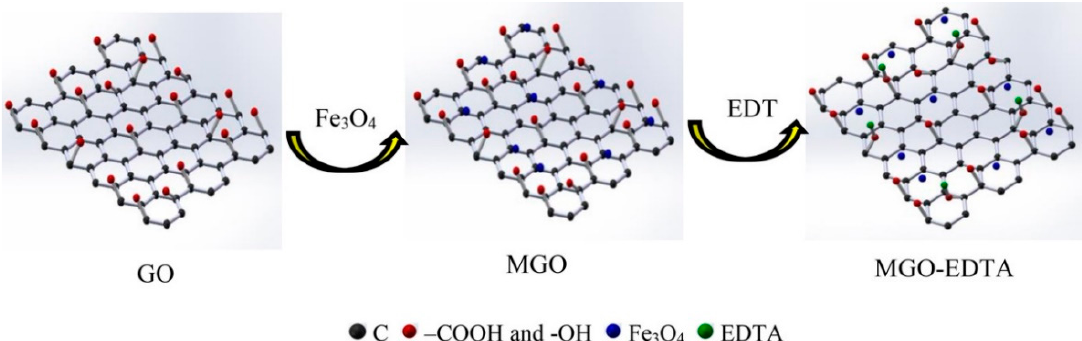
Figure 9. Illustration for the preparation of MGO − EDTA. Reprinted with permission from [91]. Copyright@ John Wiley & Sons.